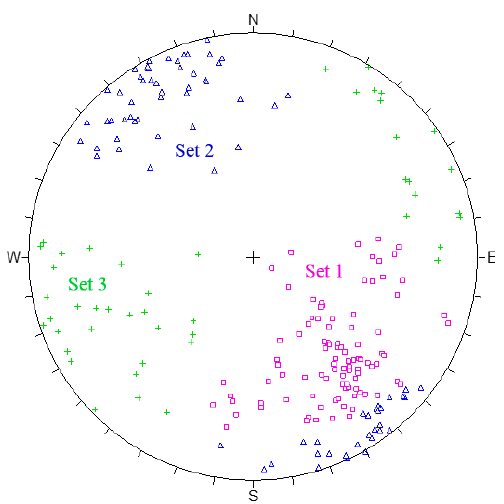
Figure 5. Grouping of the fractures according to the orientations.